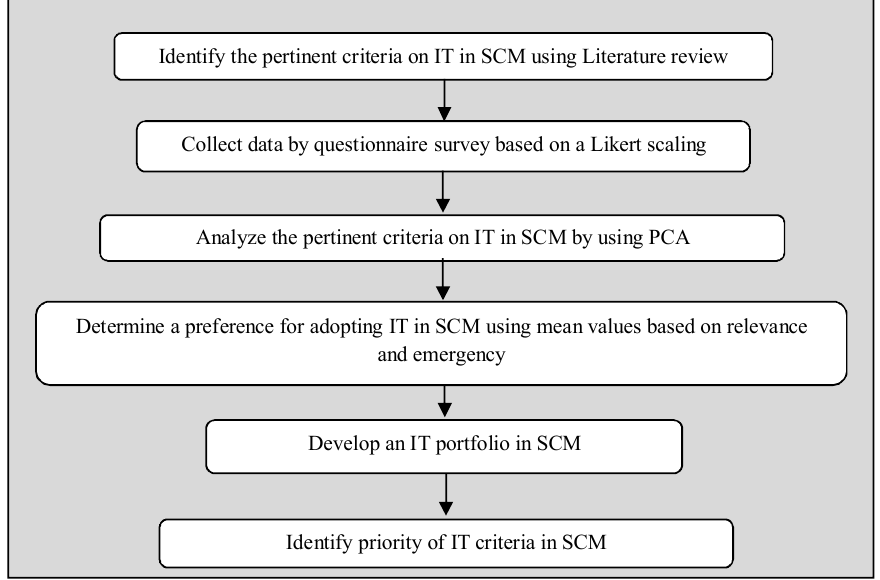
Fig. 2. The proposed